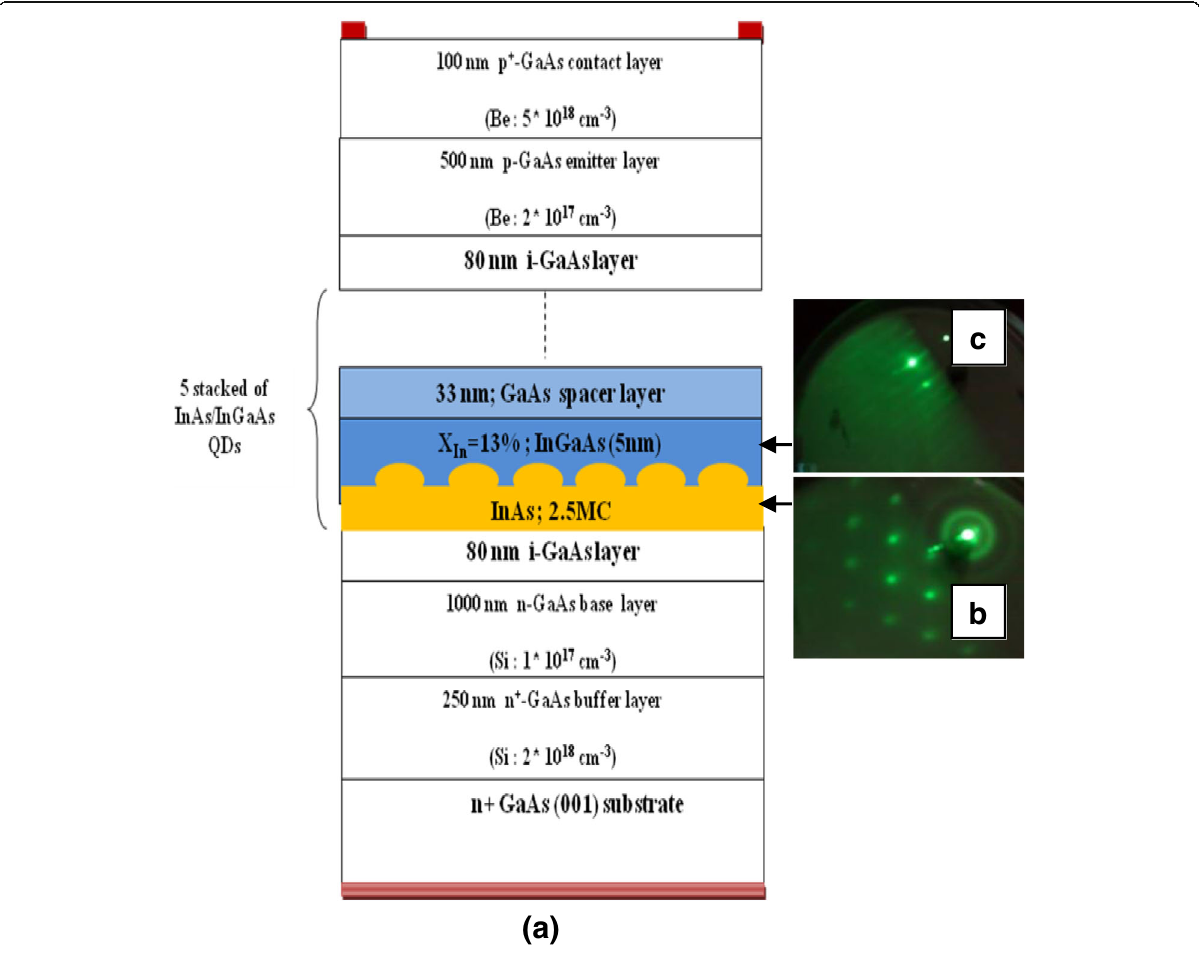
Fig. 1 a Schematic layer structure of the five-layer stacked InAs/InGaAs QDs SC grown on (001) n + -GaAs substrate. b RHEED patterned after growth of 2.5 ML of InAs (three-dimensional growth). c RHEED patterned during growth of 5 nm InGaAs (two-dimensional growth)